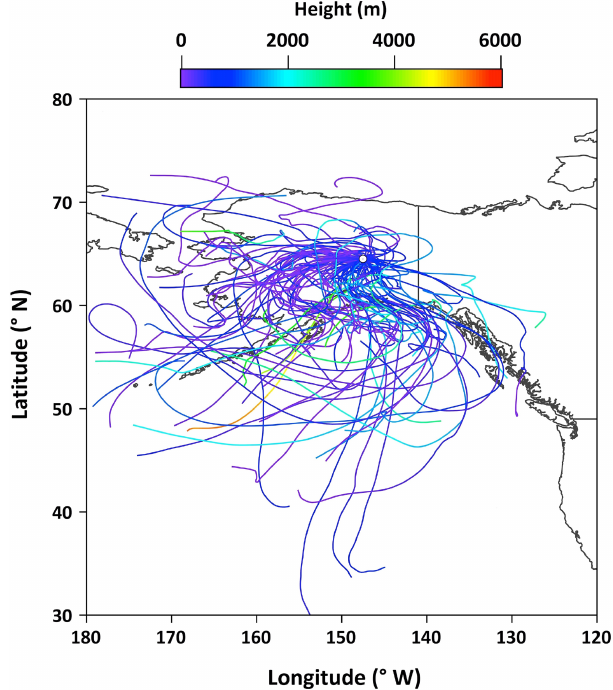
Figure 3. The air mass backward trajectories over the observation site during the collection of aerosol samples. The color scale shows the height of the air parcel.